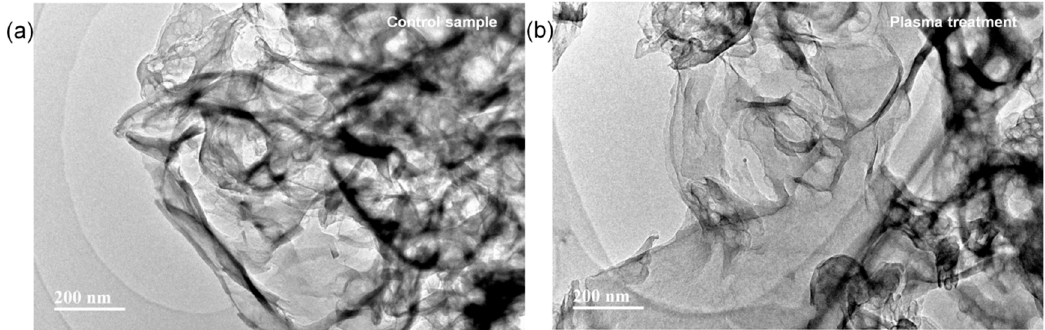
Figure 2. TEM images of ( a ) control, and ( b ) plasma-treated samples. (Plasma treatment time: 300 s; power: 60 W).